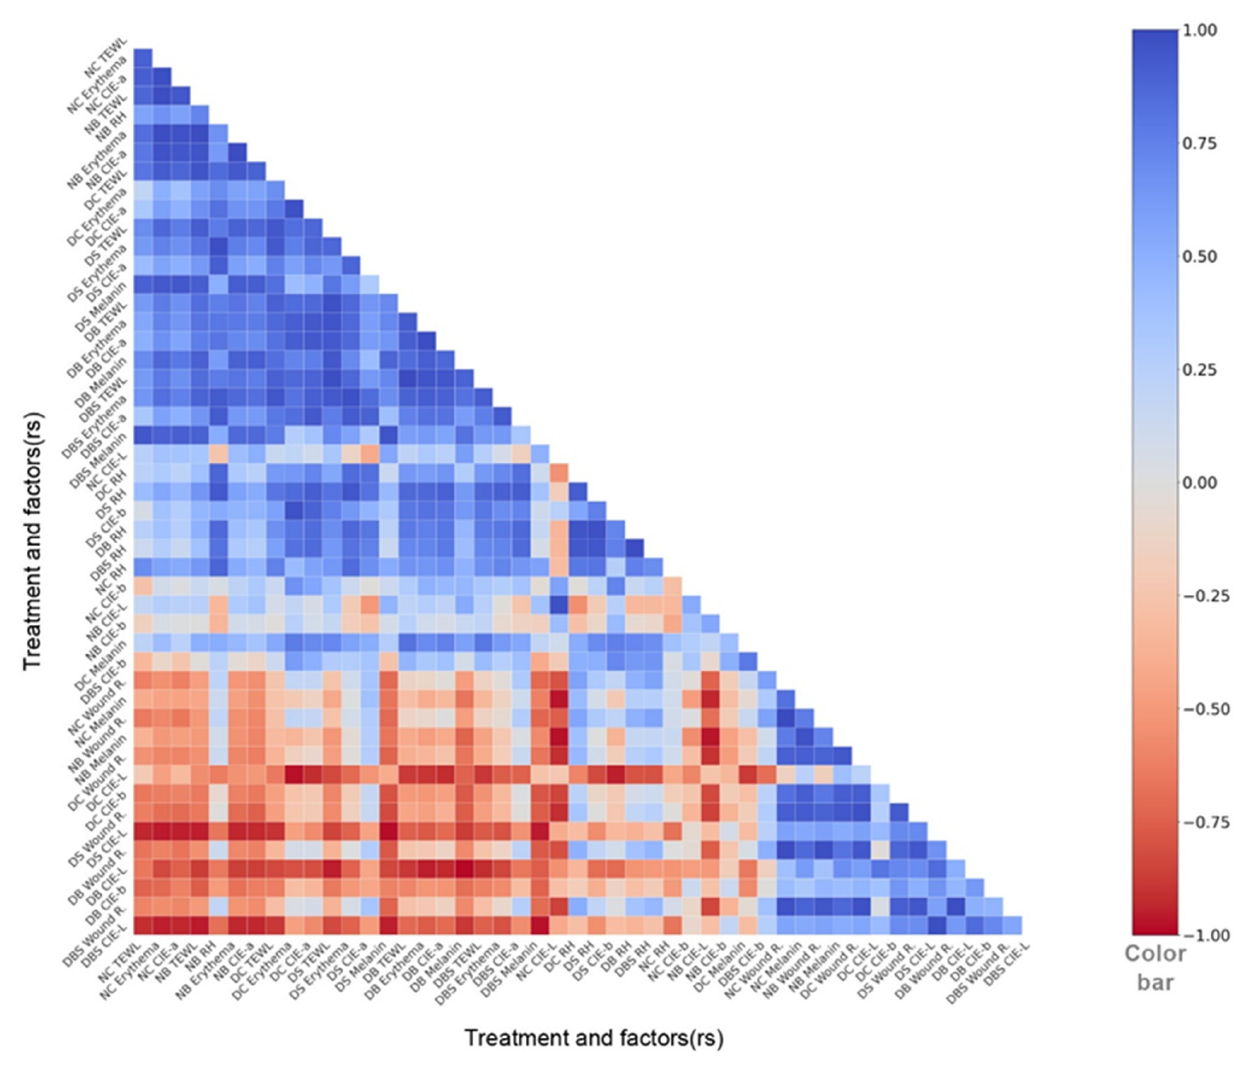
Figure 1. Correlation between wound recovery and skin surface characteristic indicators. Correlation heatmap of Wound R. (%), transdermal water loss (TEWL) (g/m 2 /h), relative humidity around the wound (RH), skin pigmentation (melanin and erythema), and skin coloration (CIE-L*, Commission Internationale d’Eclairage L*; CIE-a*, Commission Internationale d’Eclairage a*; CIE-b*, Commission Internationale d’Eclairage b*) generated via Spearman’s rank correlation coefficient statistics. The blue color represents positive correlation, red color represents negative correlation, and the saturation of color represents the level of correlation. NC: wounded normal control; NB: wounded normal mice treated with bacterial fiber membrane; DC: wounded diabetic mice normal control; DS: wounded diabetic mice treated with Suile; DB: wounded diabetic mice treated with bacterial fiber membrane; DBS: wounded diabetic mice treated with bacterial fiber membrane and Suile. NC/NB Wound R./TEWL/RH/melanin/erythema/CIE-L*/CIE-a*/CIE-b* represent wound recovery, transdermal water loss, relative humidity around the wound, melanin content, erythema content, CIE-L*, CIE-a*, and CIE-b*, respectively, in normal mice. DC/DS/DB/DBS Wound R./TEWL/RH/melanin/erythema/CIE-L*/CIE-a*/CIE-b* represent wound recovery, transdermal water loss, relative humidity around the wound, melanin content, erythema content, CIE-L*, CIE-a*, and CIE-b*, respectively, in diabetic mice. ( n = 36 with C57BL/6JNarl mice and n = 27 with BKS.Cg-Dock7m +/+ Leprdb/JNarl mice).